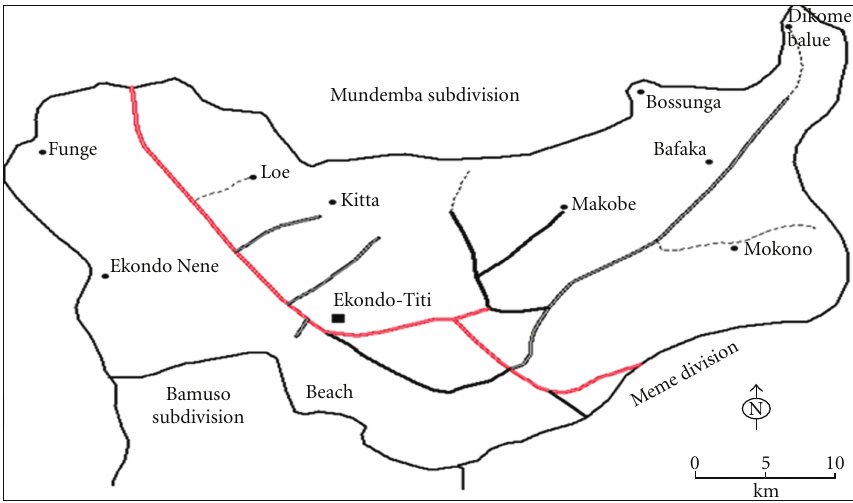
Figure 1: Administrative map of Ekondo-Titi sub-Region